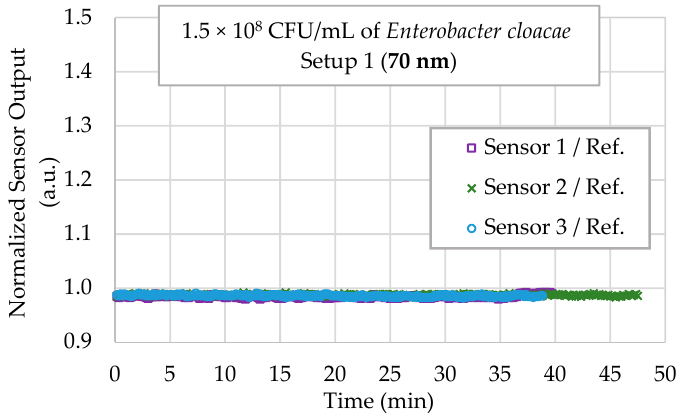
Figure 11. Sensor responses for 70 nm gold-coated U-shaped probe for selectivity testing in a 1.5 × 10 8 CFU/mL Enterobacter cloacae concentration with Setup 1.